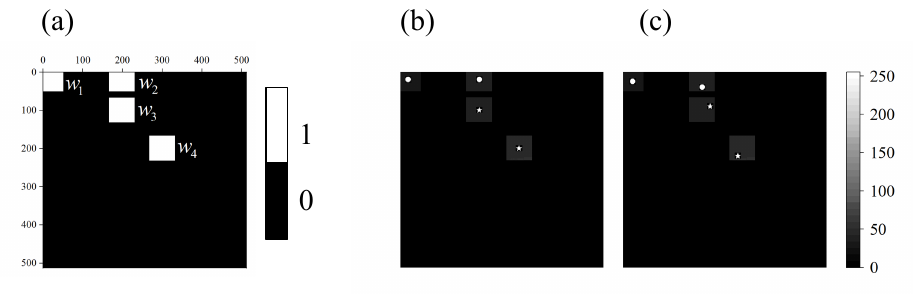
Figure 6. The four window functions for four targets: ( a ) is the four-window function, ( b ) is the windowed image at moment t 1 , and ( c ) is the windowed image at moment t 2 .